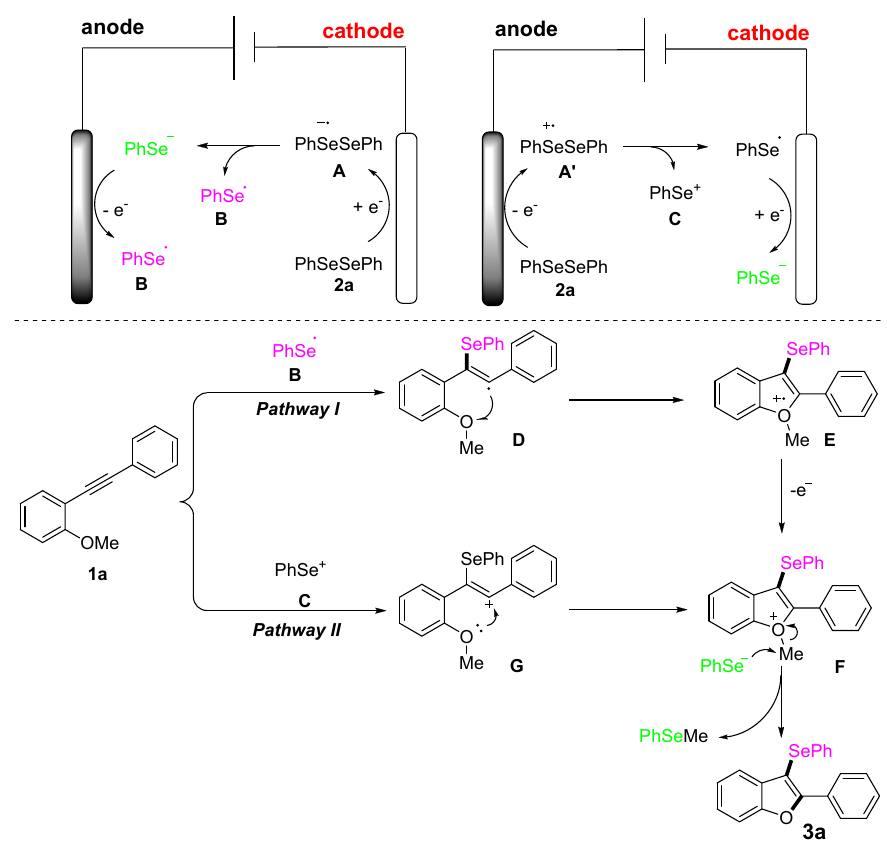
Scheme 6. Proposed